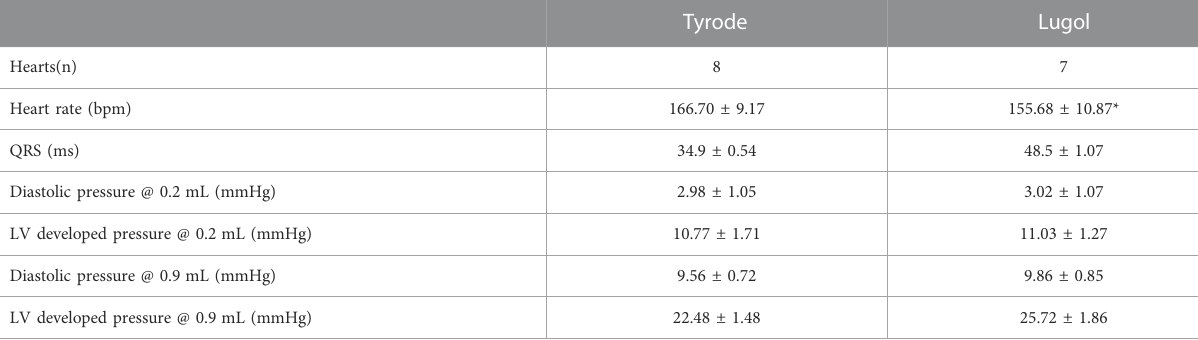
TABLE 1 Langendorff perfused isolated rabbit hearts in sinus rhythm had an indwelling balloon placed within the left ventricle (LV) that was in fl ated to an initial volume of 0.2 mL then in fl ated to a volume of 0.9 mL to dilate/stretch the LV. The LV was irrigated with Tyrode followed by 0.5 mL Lugol (120 mM KI, 38.6 mM I 2 ) over 10 s prior to a Tyrode wash. Lugol decreased heart rate and prolonged the QRS interval of the pseudo-ECG. Prolonged QRS is an expected consequence of Purkinje fi bre ablation. Diastolic pressure and left ventricular developed pressure (LVDP, an index of contractility) were not altered by exposure to Lugol, indicatingalackofeffectuponthecontractileresponsetostretch.Dataaremean±SEMfrom8heartsand24stretchesforTyrodeand7heartsand21stretchesfor Lugol, Statistical analysis of heart rate and QRS was by paired t -test on the means from each heart. The effects of stretch and Lugol on pressures was tested by 2 way ANOVA, with stretch and Lugol as factors. There was a signi fi cant effect of stretch ( p < 0.05) but not Lugol or factor interaction ( p > 0.05). There was a signi fi cant effect of stretch in all Holm-Sidak multiple pairwise